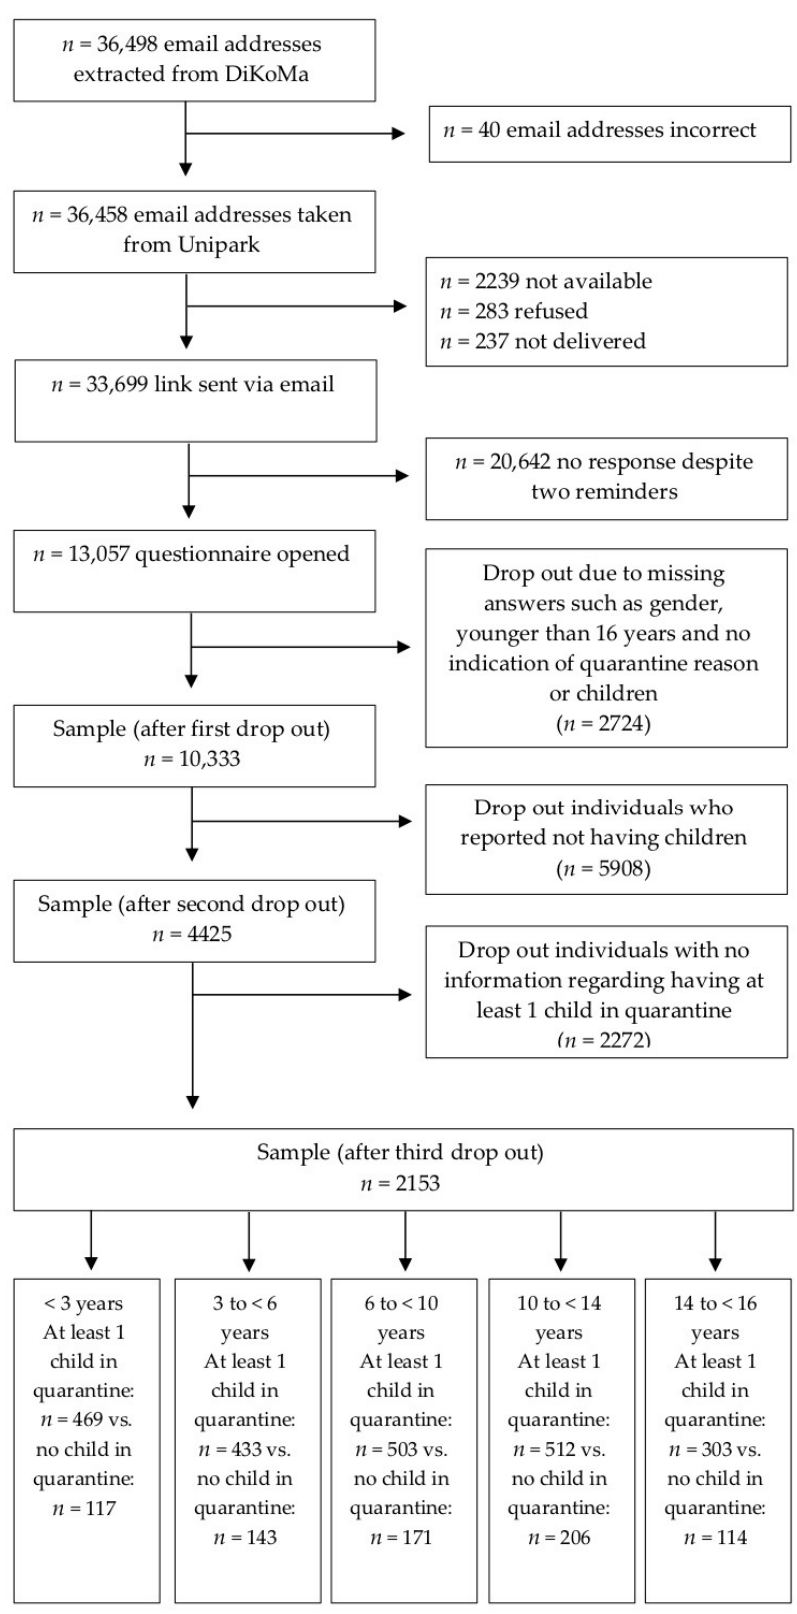
Figure 1. Study population; all n- values refer to the number of parental statements.